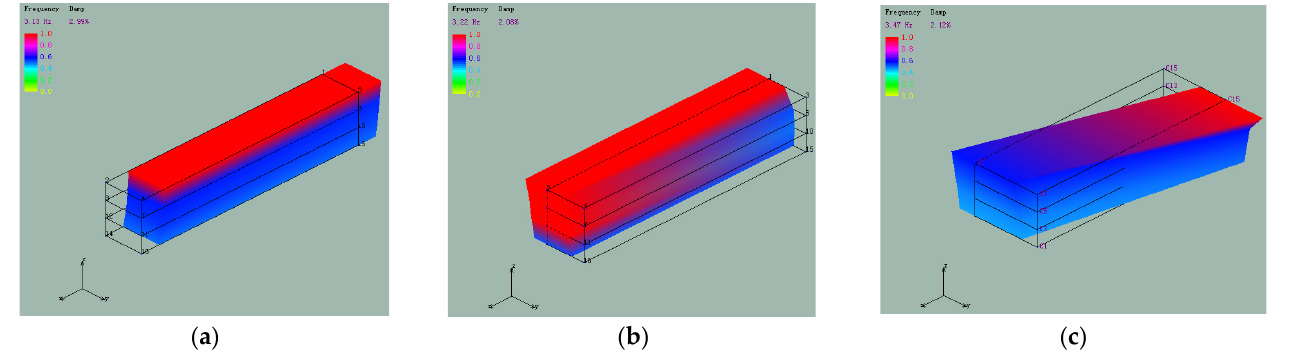
Figure 19. Vibration modes of structures of different order: ( a ) first order mode; ( b ) second order mode; ( c ) third order mode. Table 3. Analysis results of natural vibration characteristics.